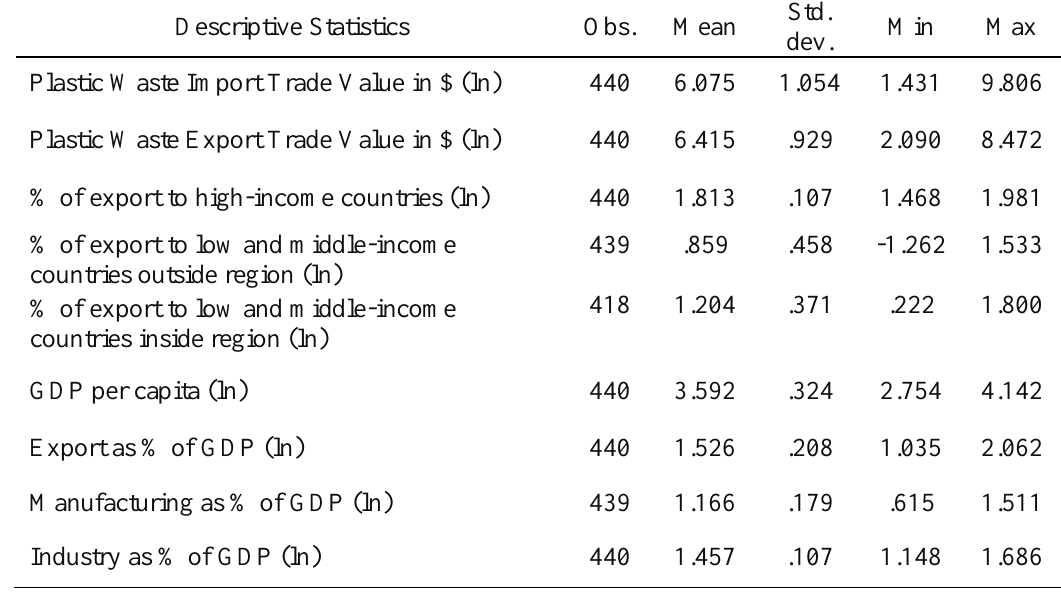
Table 2. Descriptive Statistics for 40 Non-High-Income Countries Descriptive Statistics